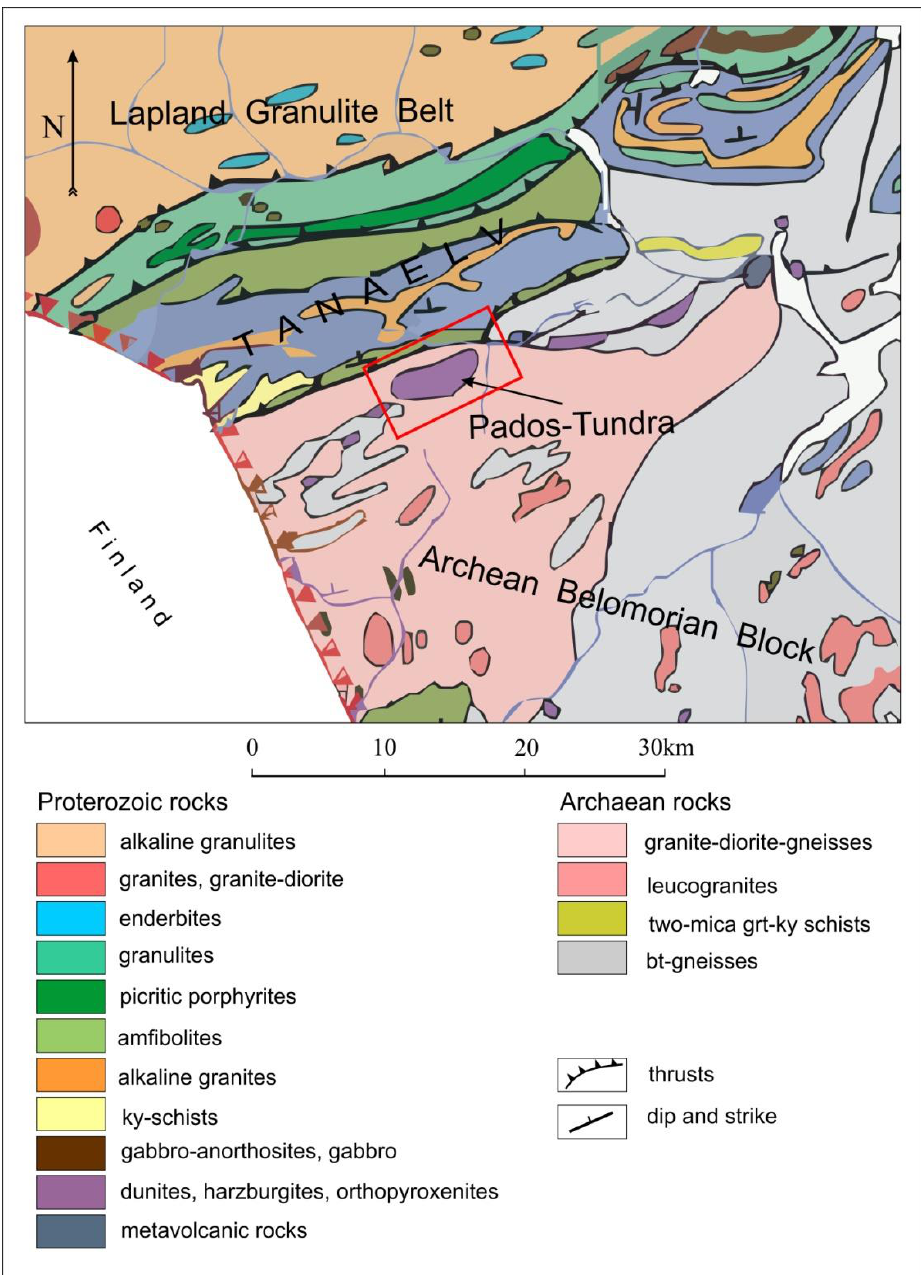
Figure 2. Geological map of the Pados-Tundra area.